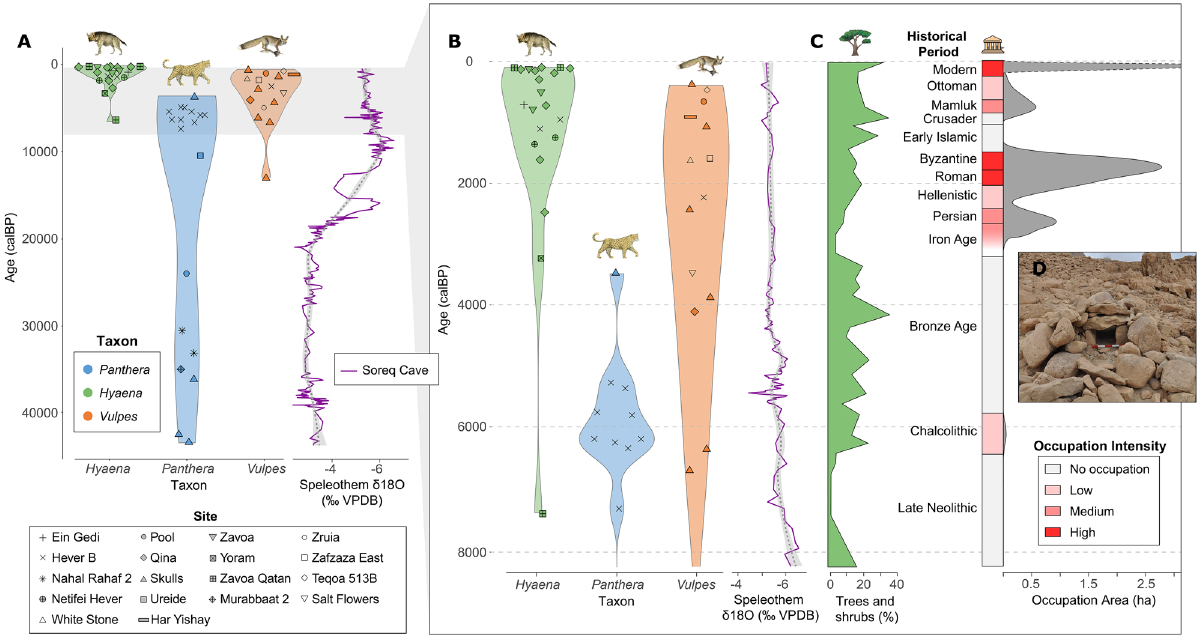
Figure 4. Distribution of radiocarbon dates by period, site, and taxon in relation to changes in local proxies for climate, vegetation, and human intensity in the Judean Desert. ( A ) Several leopard specimens were dated to the Late Pleistocene (~ 20,000–40,000 calBP) but ( B ) most of the remains are dated to the Holocene (< 4000 calBP). ( C ) Percentage of trees and shrubs derived from pollen data in 29 and human intensity calculated as settlement occupation area (Table 1). ( D ) Box trap (leopard trap) from Nahal Hever. Note that a large quantity of Dead Sea pollen may originate upstream the Jordan River, reflecting vegetation conditions further north. Occupation area calculated from drawing convex hulls around archaeological sites in the Ein Gedi oasis. Soreq δ 18 O data from 62 . The red star denotes the time when the Judean Desert was settled during the Iron Age, which is coincident with the disappearance of leopard remains and the increase of hyena remains in the zooarchaeological record.